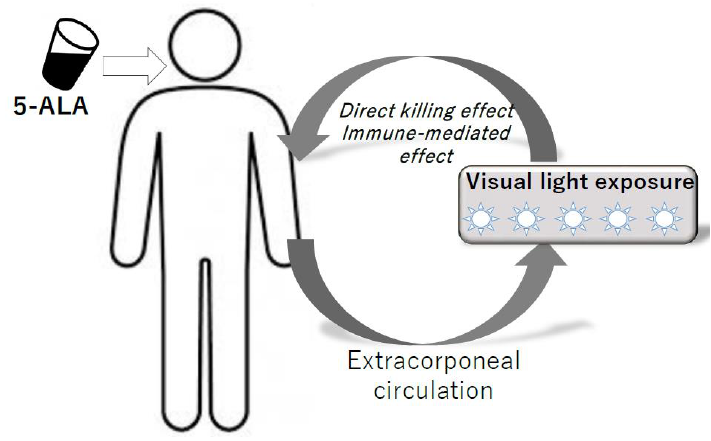
Figure 4. Model of ALA-PDT for hematopoietic malignancies using extracorporeal circulation system. 5ALA is administered orally, and then visible light is exposed to ATL cells and normal lymphocytes in peripheral blood using the extracorporeal circulation system. Direct killing effects and immune-modulating effects are expected.